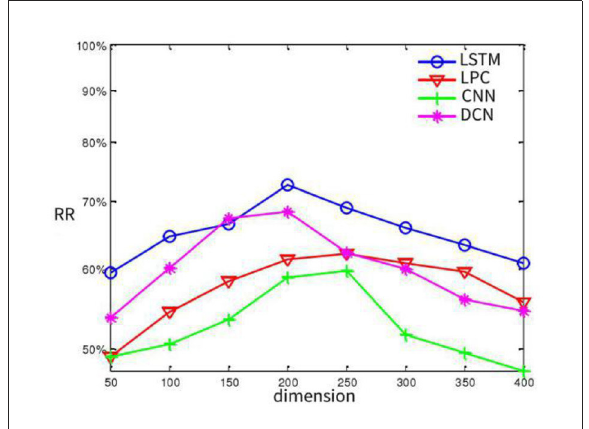
FIGURE5 The relation between recognition rate and dimension